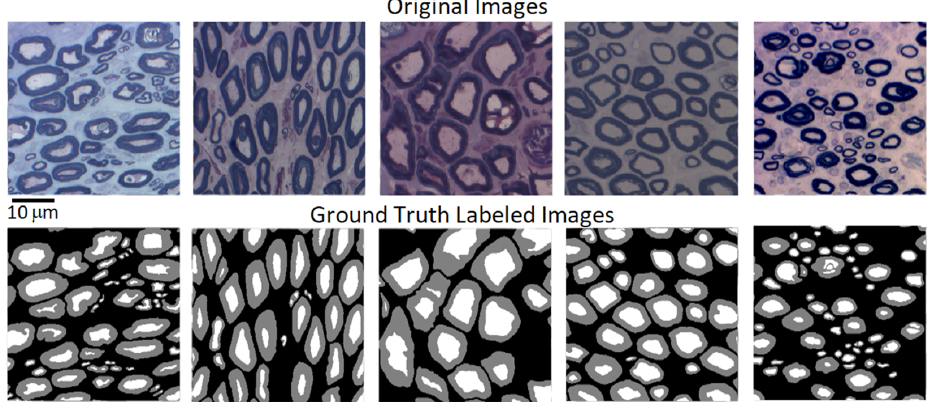
Figure 1 . Five samples of the original images and their corresponding ground truth labels. Labels contain three classes: axon (white), myelin (gray), and background (black). The size of each sample is 512 × 512 pixels with pixel size of 0.15 × 0.15 μ m .